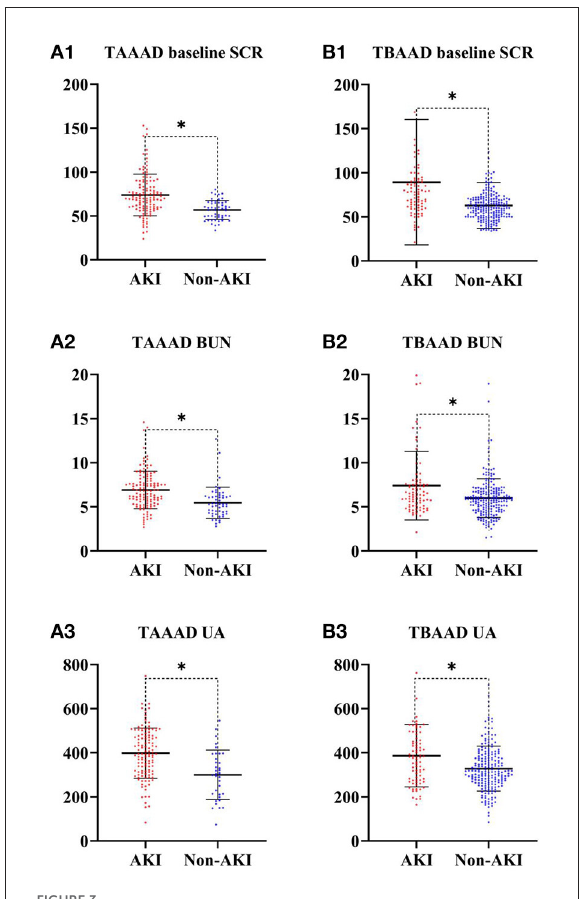
FIGURE3 SCR, BUN and UA differences between AKI and Non-AKI groups. * represents statistical differences. (A) Is from the TAAAD data; (B) is from the TBAAAD